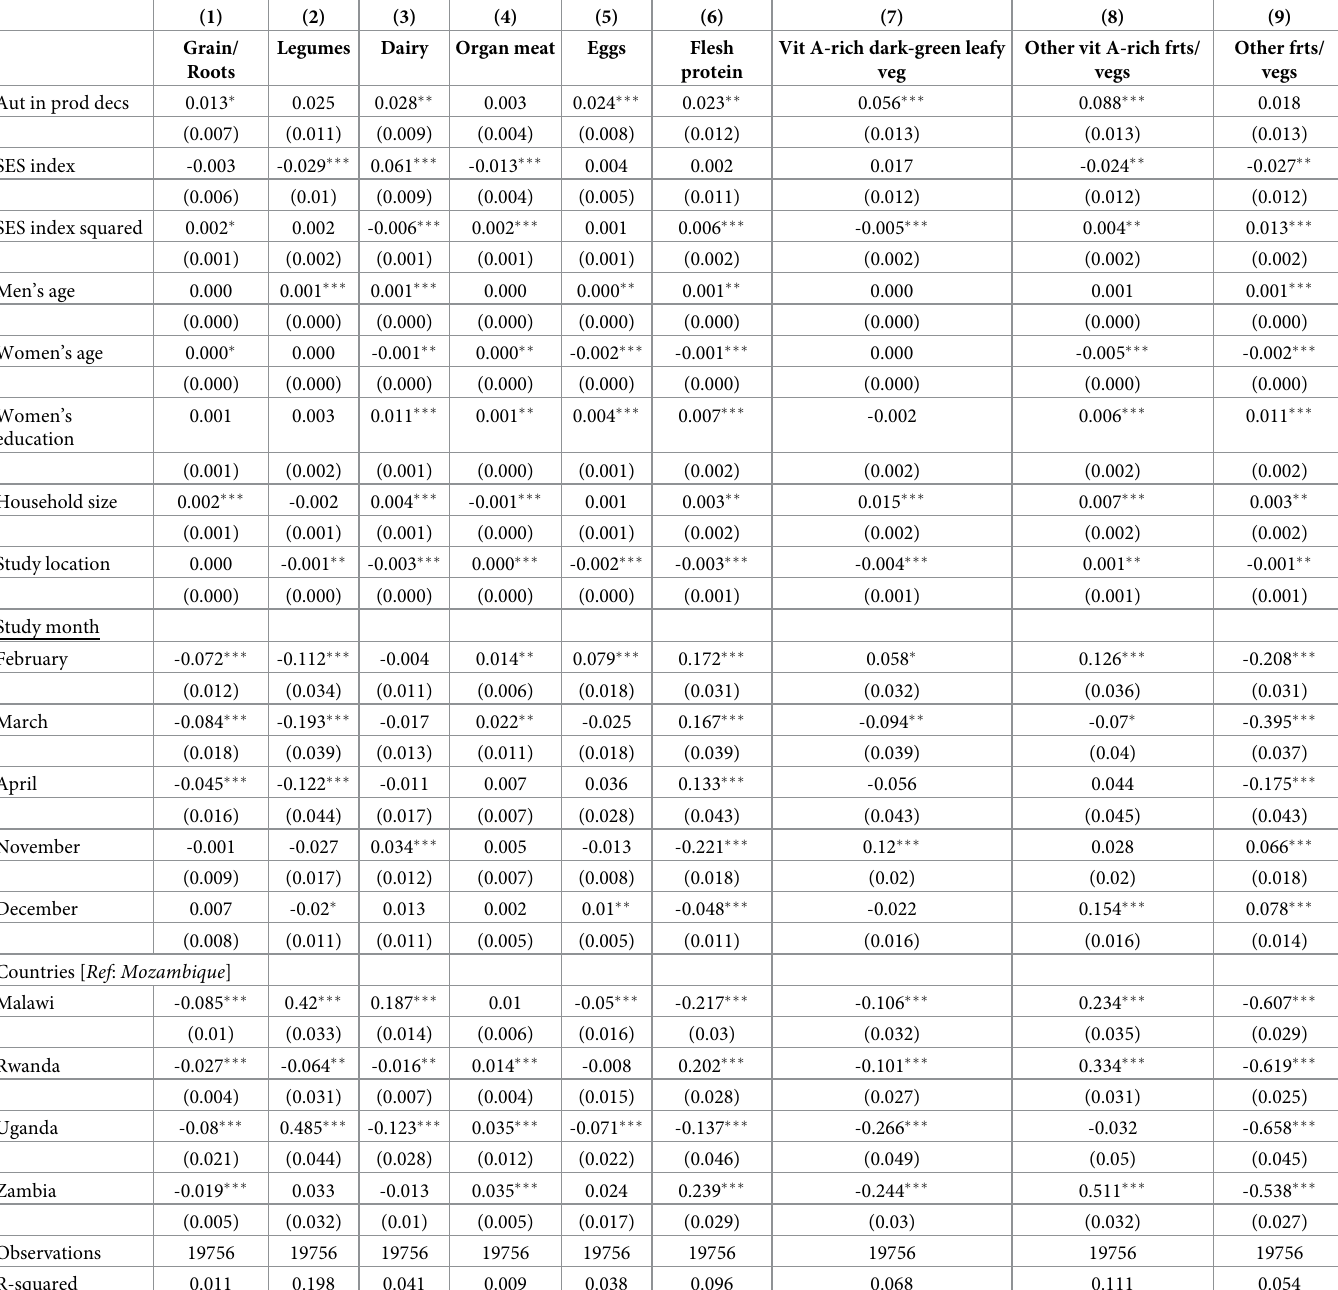
Table 15. LPM regression for food groups consumed–production domain (autonomy in � 1 activity linked to